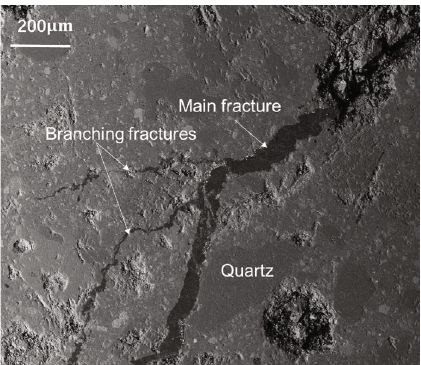
Figure 6: Microfracture morphology under a scanning electron